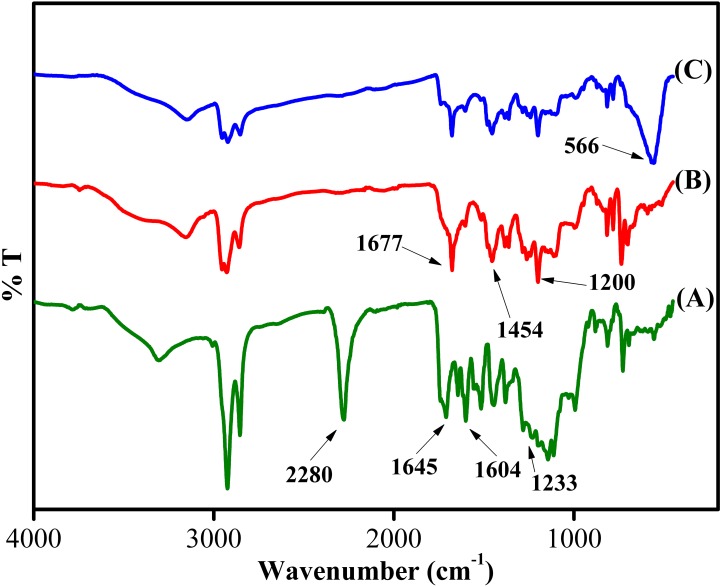
FTIR spectra of synthesized adsorbent.FTIR spectra of (A) Sp-TDI, (B) Sp-TDI-calix and (C) MSp-TDI-calix.